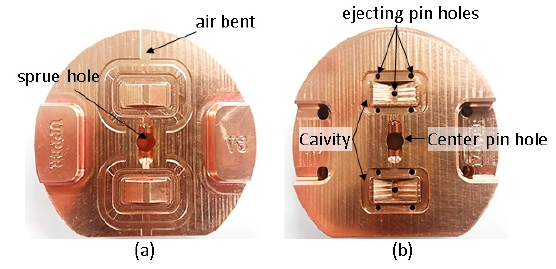
Figure 6. Machined mold insert: ( a ) fixed side; ( b ) movable side.